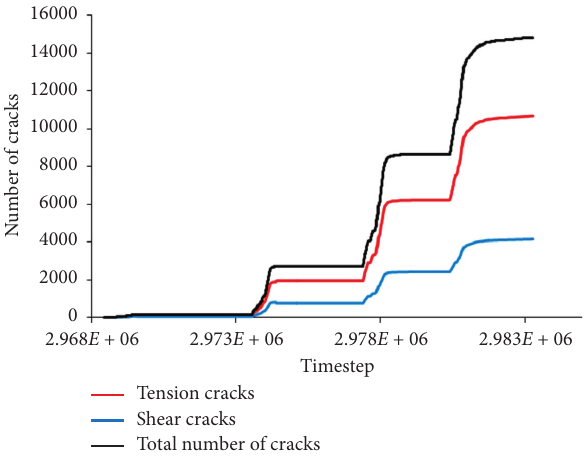
Figure 18: The number of microcracks during